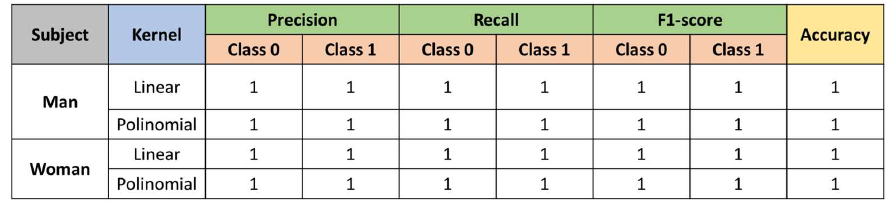
Figure 12. Results of the SVM classifier.